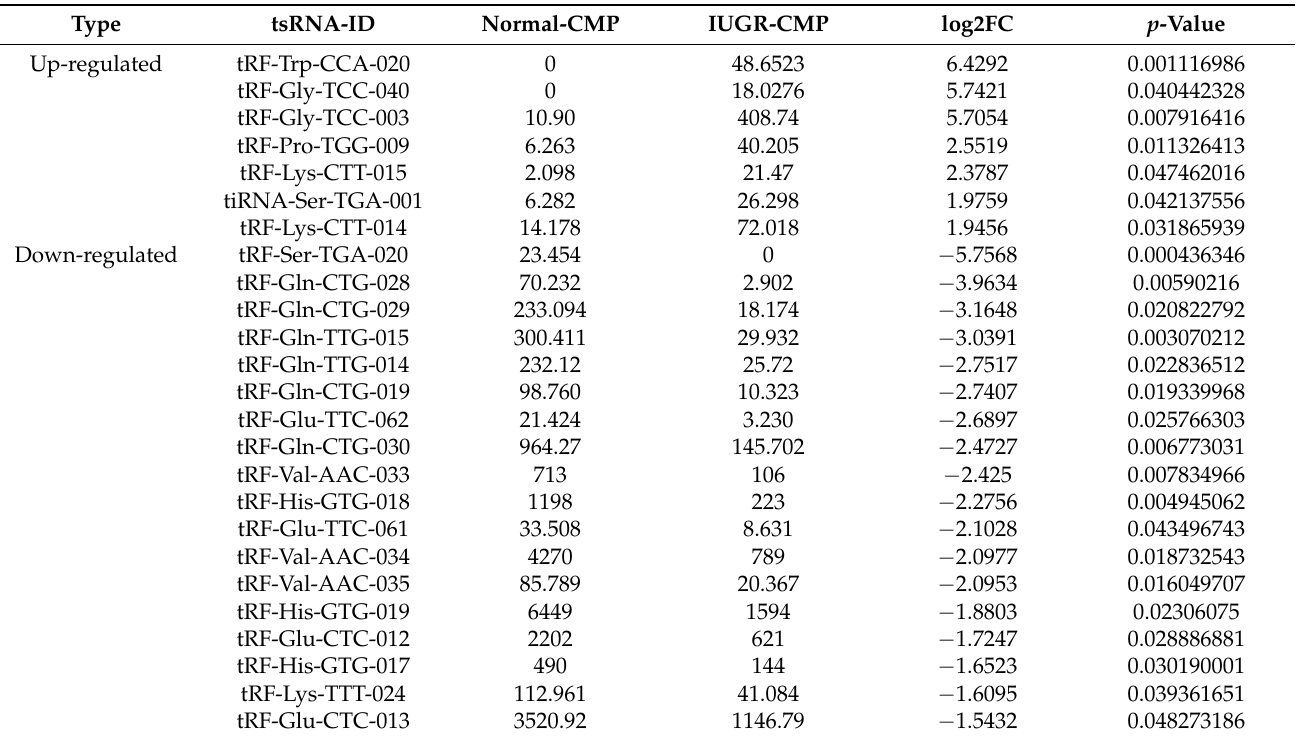
Table 2. List of tsRNA populations differentially expressed in the spleen between Normal and IUGR